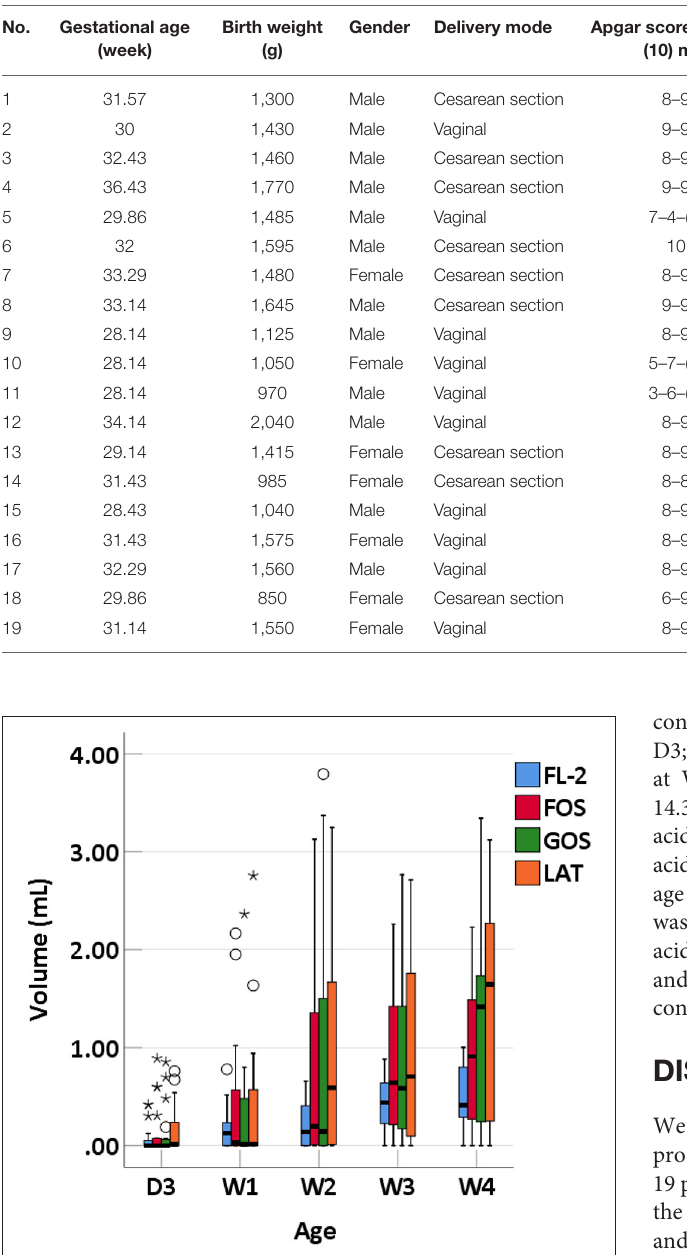
FIGURE 1 | Total volume of intestinal gases of preterm infants of different ages. D3, 3 days after birth; W1, 1 week after birth; W2, 2 weeks after birth; W3, 3 weeks after birth; W4, 4 weeks after birth; LAT, lactose; FOS, fructooligosaccharide; FL-2, milk oligosaccharide; GOS, galactooligosaccharide; * , extreme value; ◦ , discrete value.